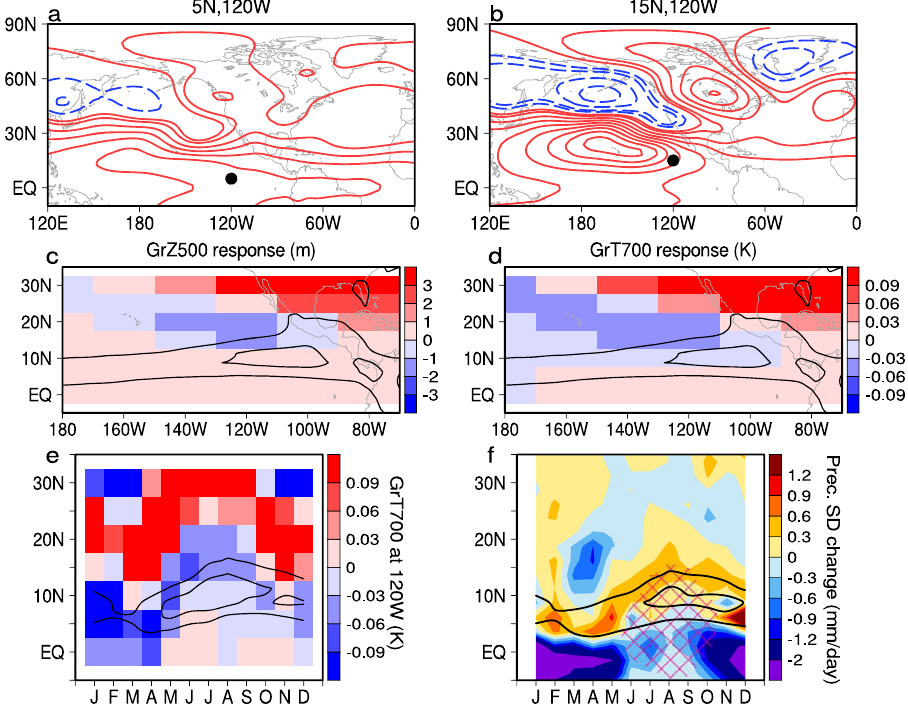
Fig. 4 Simulated teleconnection towards Greenland in response to tropical heating. Response of summertime 250-hPa geopotential height to an idealised heating centred at ( a ) 5°N, 120°W and ( b ) 15°N, 120°W (black circles, respectively) in the linear baroclinic model (LBM) experiments (Contours for ±1, ±2, ±4, ±6, ±8, … m; red for positive, blue for negative). Spatial distribution of responses of ( c ) 500-hPa geopotential height and ( d ) 700-hPa temperature over Greenland (60° – 85°N, 20° – 60°W) to a single heating whose centre is located at each grid. Response is plotted at the centre of the heating location. ( e ) As in ( d ), but for latitude – time section in response to a heating at 120°W. ( f ) Latitude – time section of standard deviation difference between the periods 2000 – 2020 and 1979 – 1999 for observed precipitation averaged over 120° – 160°W. Black contours indicate observed mean precipitation for 1979 – 2020 (contour interval is 5 mm day − 1 ), and hatching in ( f ) indicates the regions with easterly at upper